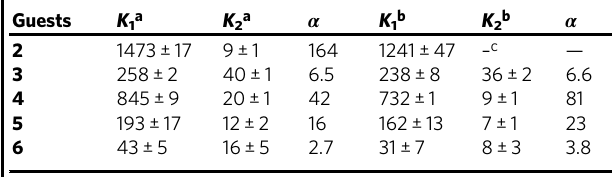
Table 2 Association constant K a values (M − 1 ) of macrocycle 1 with neutral molecules at 25 °C as determined by